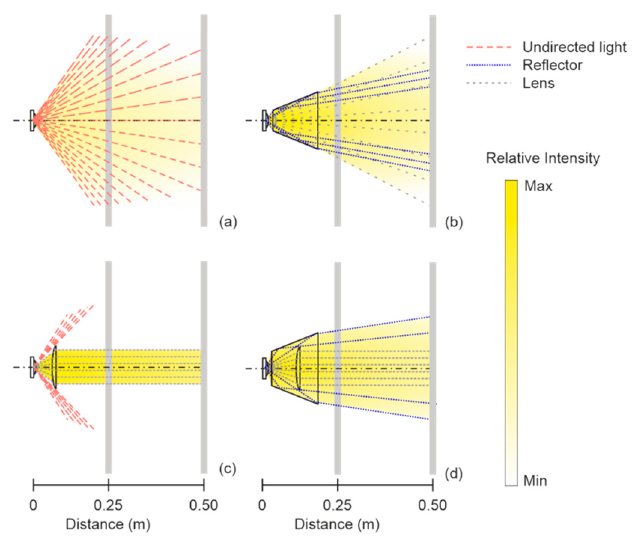
Figure 4. Operation radius of an LED ( a ) without a reflector; ( b ) with a reflector; ( c ) with a lens; ( d ) with TIR.